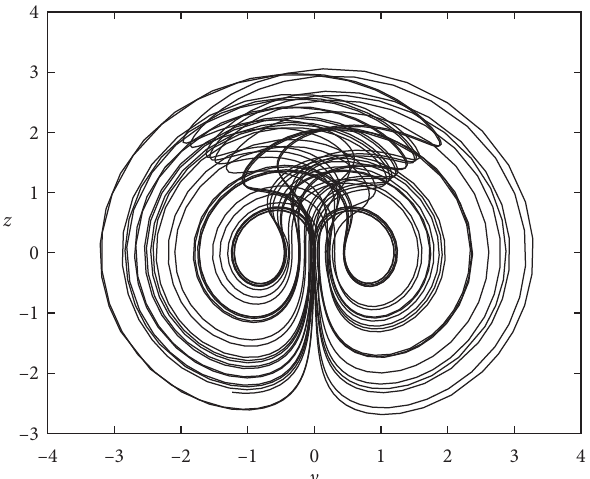
Figure 5: An apparently continuous broadband frequency